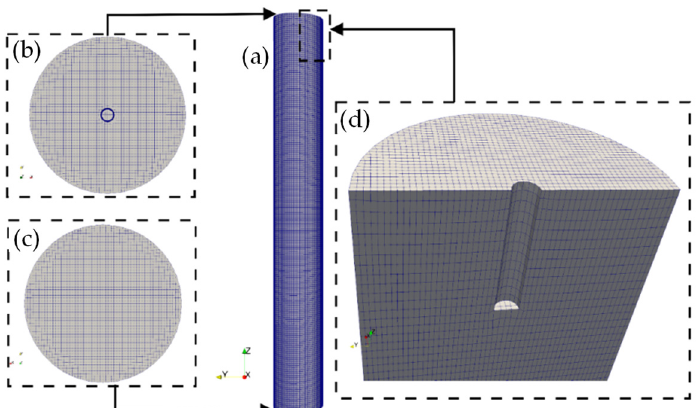
Figure 3. 3D hexahedral computational mesh: ( a ) downer reactor; ( b ) upper view of the downer reactor annular and central inlets for N 2 and air-particles, respectively; ( c ) bottom view of the downer reactor outlet; ( d ) cut-out section of the downer reactor mesh showing details of the annular and central inlets.